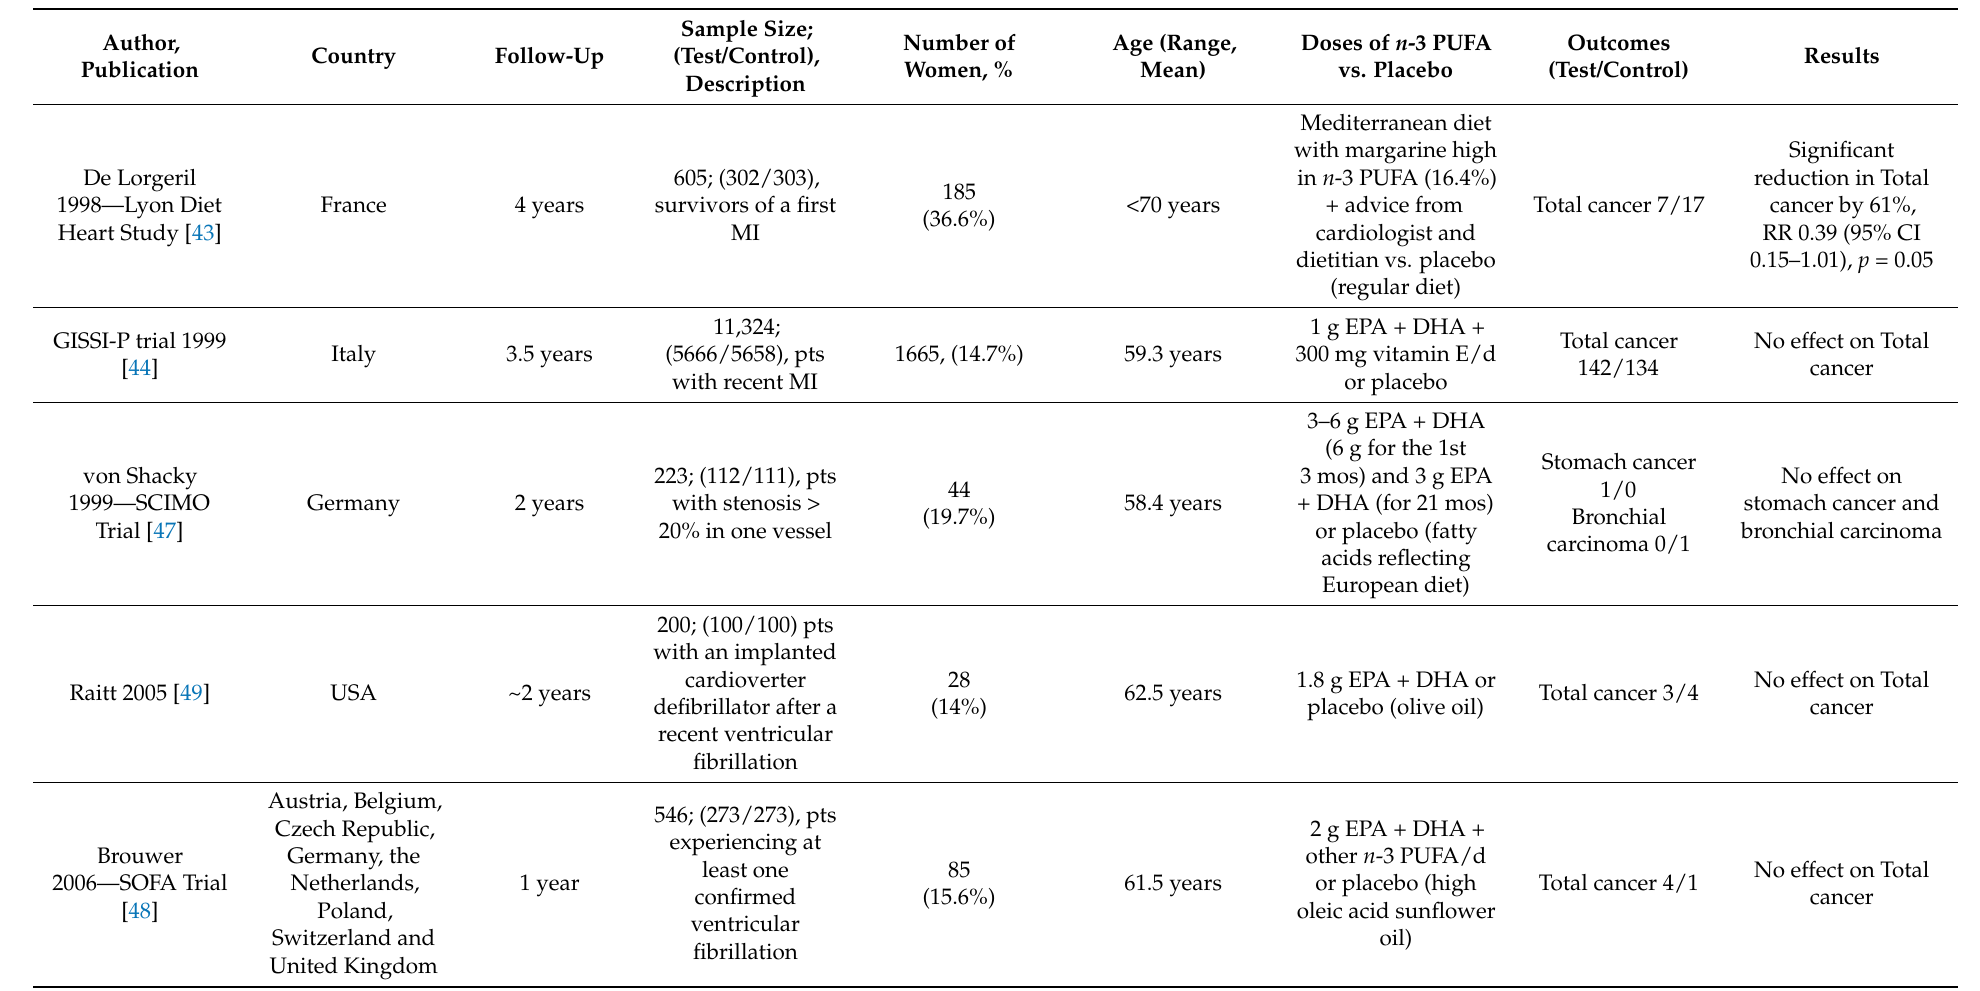
Table 2. Characteristics of RCTs studying the effects of n -3 PUFA on cancer and cancer-related